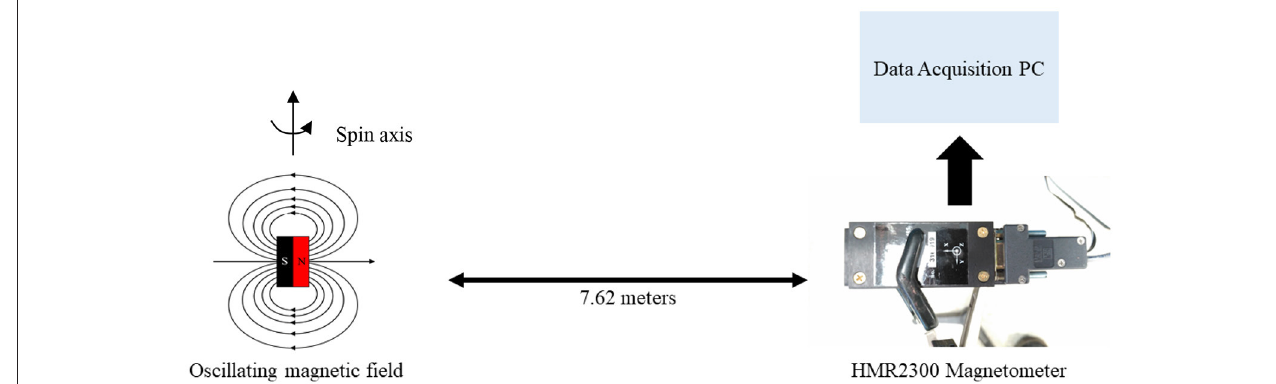
FIGURE 3 | Diagram of signal range test.